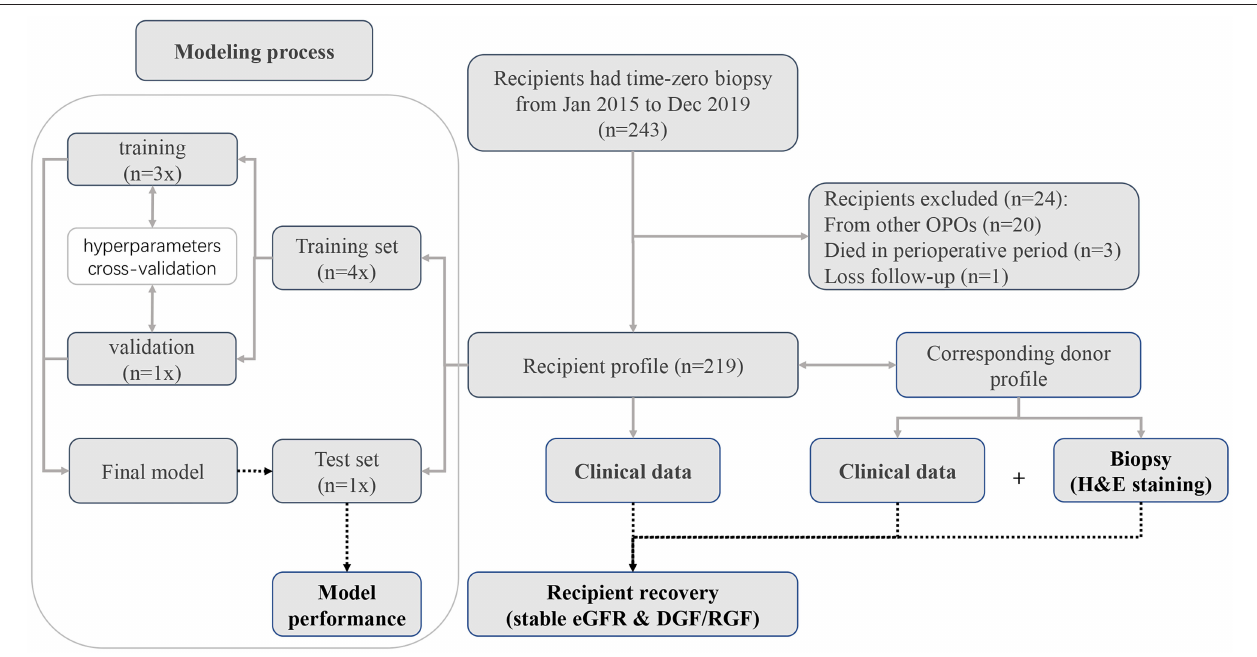
FIGURE 1 | Patient recruitment diagram. In total, pretransplantation biopsy slides were available for 243 recipients. Twenty recipients were excluded because the donors were from other organ procurement organizations (OPOs). Three recipients died during the perioperative period. One recipient was lost to follow-up. Finally, we included 219 recipients with complete data for deep learning analysis.